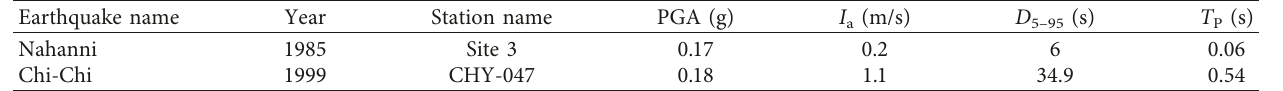
Table 4: Characteristics of earthquake ground motion used in the